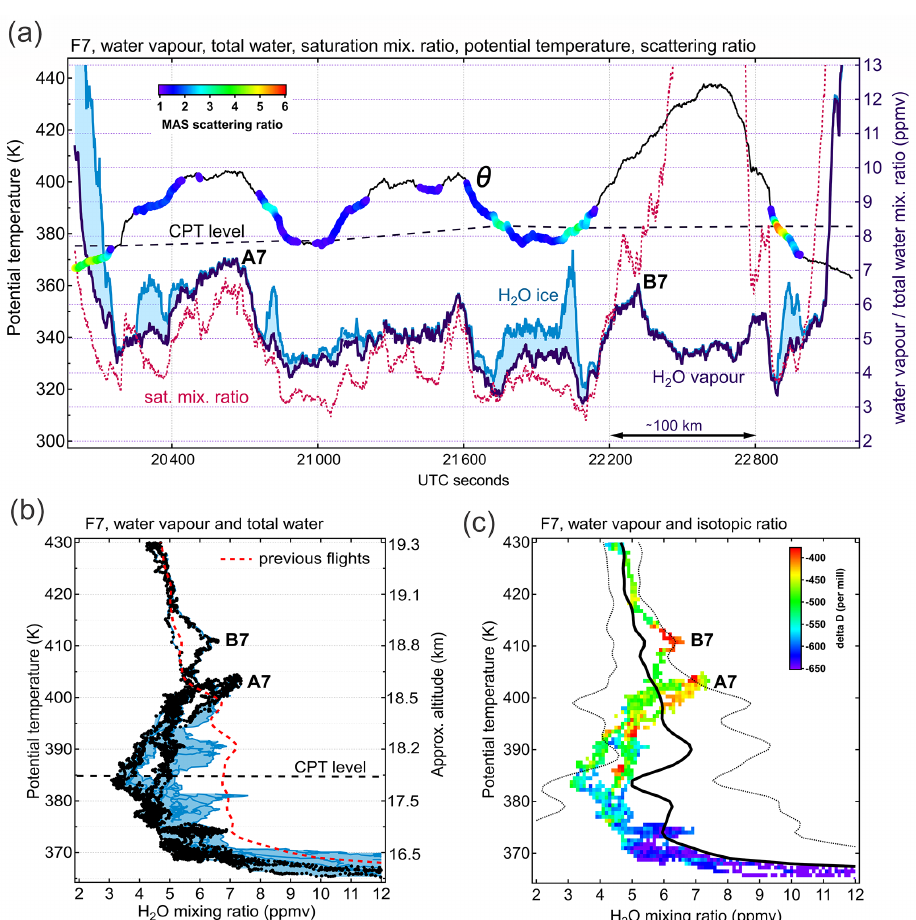
Figure 8. Results of F7 measurements (8 August) with the features of interest marked A7 and B7. (a) Time series of potential temperature θ (left-hand axis) and water vapour/total water (right-hand axis). The θ time series is tagged by cloud occurrence and colour-coded by the scattering ratio. The IWC is shown as cyan shading stacked on the water vapour curve, and the darker cyan curve depicts the total water (right-hand axis). The dashed magenta line depicts the saturation mixing ratio (right-hand axis). The CPT level displayed as the black dashed line is inferred from airborne measurements. (b) Vertical profiles of water vapour (black circles), total water (cyan) and IWC (cyan shading). The red dashed curve indicates the mean water vapour profile from the previous flights (F1–F6). (c) Binned water vapour profile with pixels colour-coded by the HDO / H 2 O isotopic ratio. The black solid curve depicts the campaign-median H 2 O profile, and the dotted curves represent 2 standard deviations